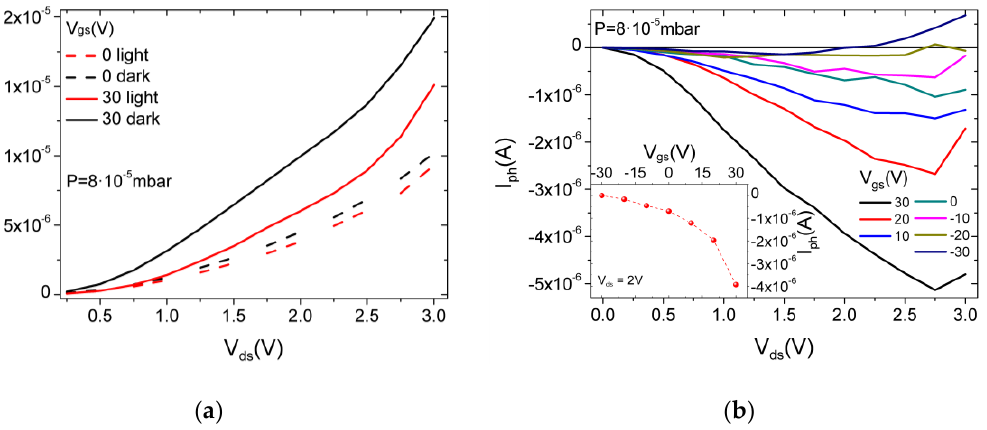
Figure 5. ( a ) I ds − V ds curves in dark and light at V gs = 0 and +30 V (dashed and solid lines); ( b ) I ph - V ds curves at different V gs . I ph vs. V gs at V ds = 2 V in the inset.